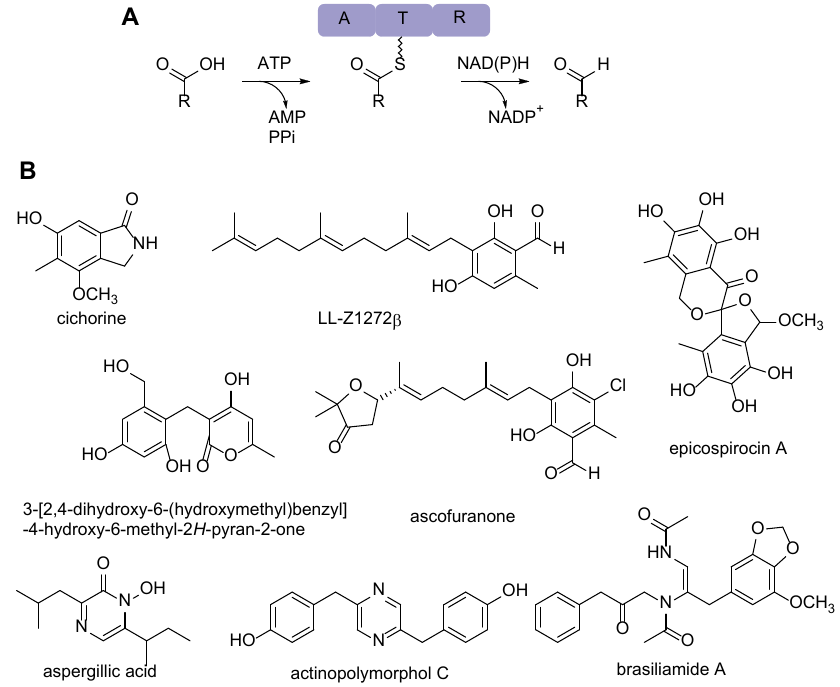
Figure 1. Carboxylic acid reduction by CARs. ( A ) CARs containing A-T-R domain architecture catalyze two-electron reduction of carboxylates to aldehydes. ( B ) Representative fungal NPs involving carboxylic acid reduction by CARs in their biosynthetic pathways. They include cichorine from Aspergillus nidulans [19], LL-Z1272b from Stachybotrys bisbyi [13], epicospirocin A from Epicoccum nigrum [14], melanin derivative from Ustilago maydis [20], ascofuranone from Acremonium egyptiacum [21], aspergillic acid from Aspergillus flavus [22], actinopolymorphol C from A. flavus [15] and brasilliamide A from Penicillium brasilianum [16].